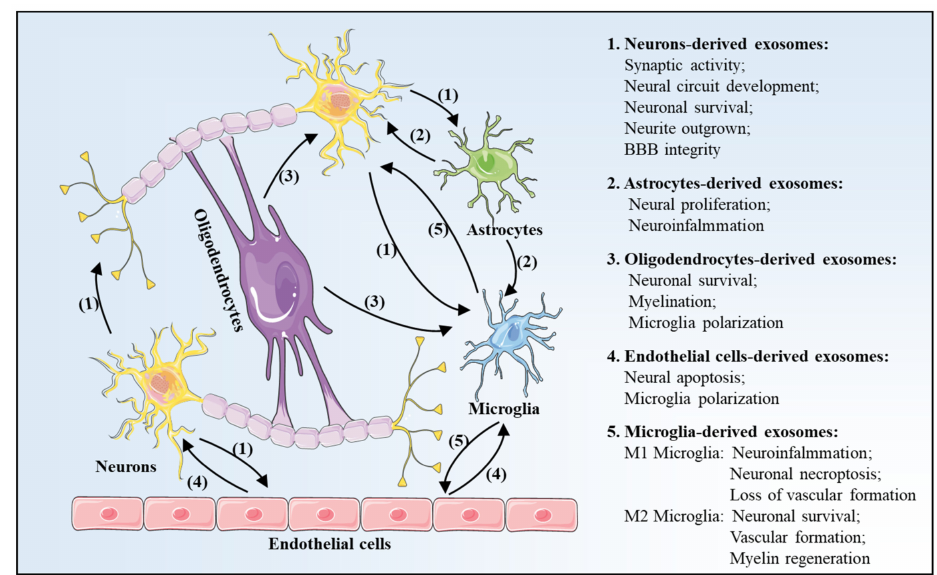
Figure 4. Schematic diagram of intercellular communication mediated by exosomes in the central nervous system (CNS) after ischemia-reperfusion (I/R) injury. Exosomes can be released by almost all cells in the CNS, including neurons, endothelial cells, astrocytes, oligodendrocytes, and microglia, and they are involved in the process of cell-to-cell communication. Acronyms: I/R, ischemia-reperfusion; CNS, central nervous system. CNS. Arrows indicate the direction of